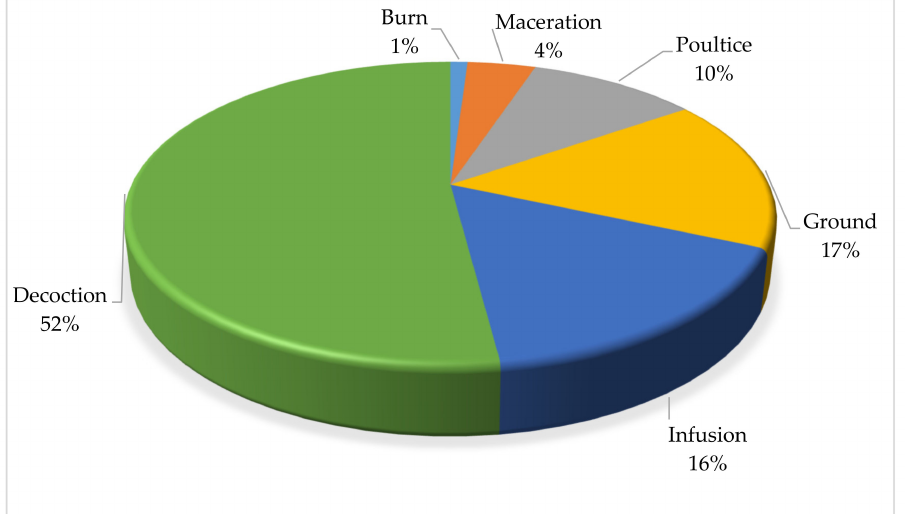
Figure 3. Distribution (%) of preparation methods for plants used in the treatment of cattle diseases in Ramotshere Moiloa local municipality, North West Province, South Africa (n = 98).